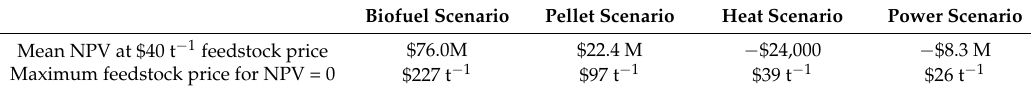
Table 4. Net present value (NPV) and ability to pay for feedstock.